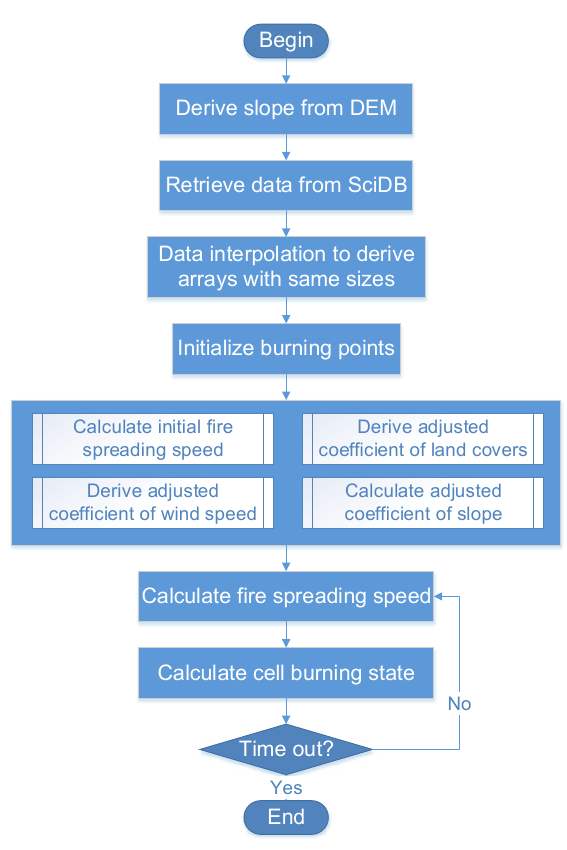
Figure 7. Forest fire simulation processing flow.